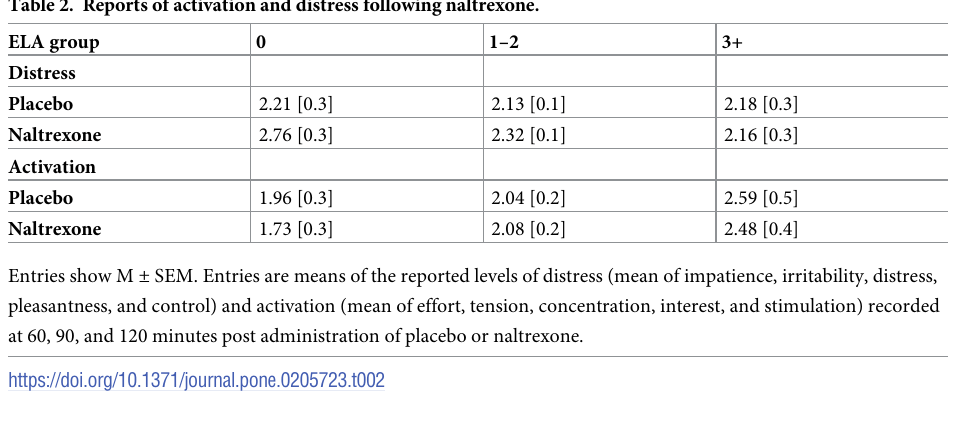
Fig 1. Saliva cortisol values in response to naltrexone in women with Low (0), Medium (1–2), and High (3+) levels of Early Life Adversity. Top panel: change in saliva cortisol from the placebo day to the naltrexone day averaged over 90–150 minutes after administration of 50 mg naltrexone or placebo. Middle panel: change in saliva cortisol on naltrexone day at each collection interval. Arrow indicates time of naltrexone or placebo administration. Bottom panel: Saliva cortisol on placebo day for the three ELA groups.